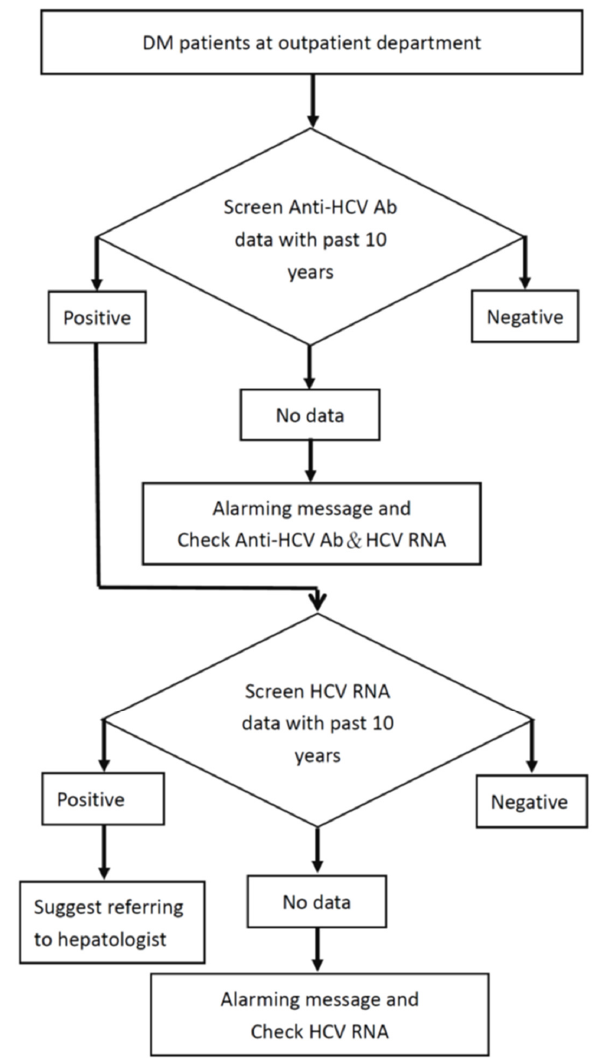
Figure 1. Hepatitis C virus screening flowchart targeting the diabetes mellitus population.